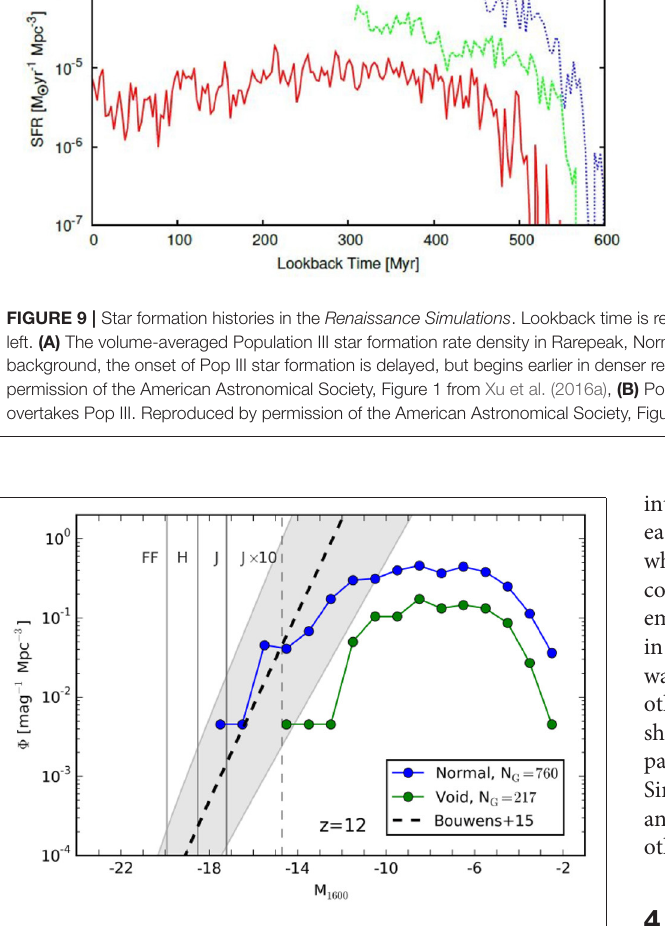
FIGURE 10 | The predicted z = 12 ultraviolet luminosity functions (ULFs) for the Normal and Void Renaissance Simulations , showing flattening at faint magnitudes M 1600 > − 15, which roughly corresponds to the transition from LMACHs to MCHs. At the bright end M 1600 < − 17, the Normal ULF is in good agreement with an extrapolation of observed ULF to z = 12 (shaded region). Reproduced by permission of the American Astronomical Society, Figure 1 from O’Shea et al.